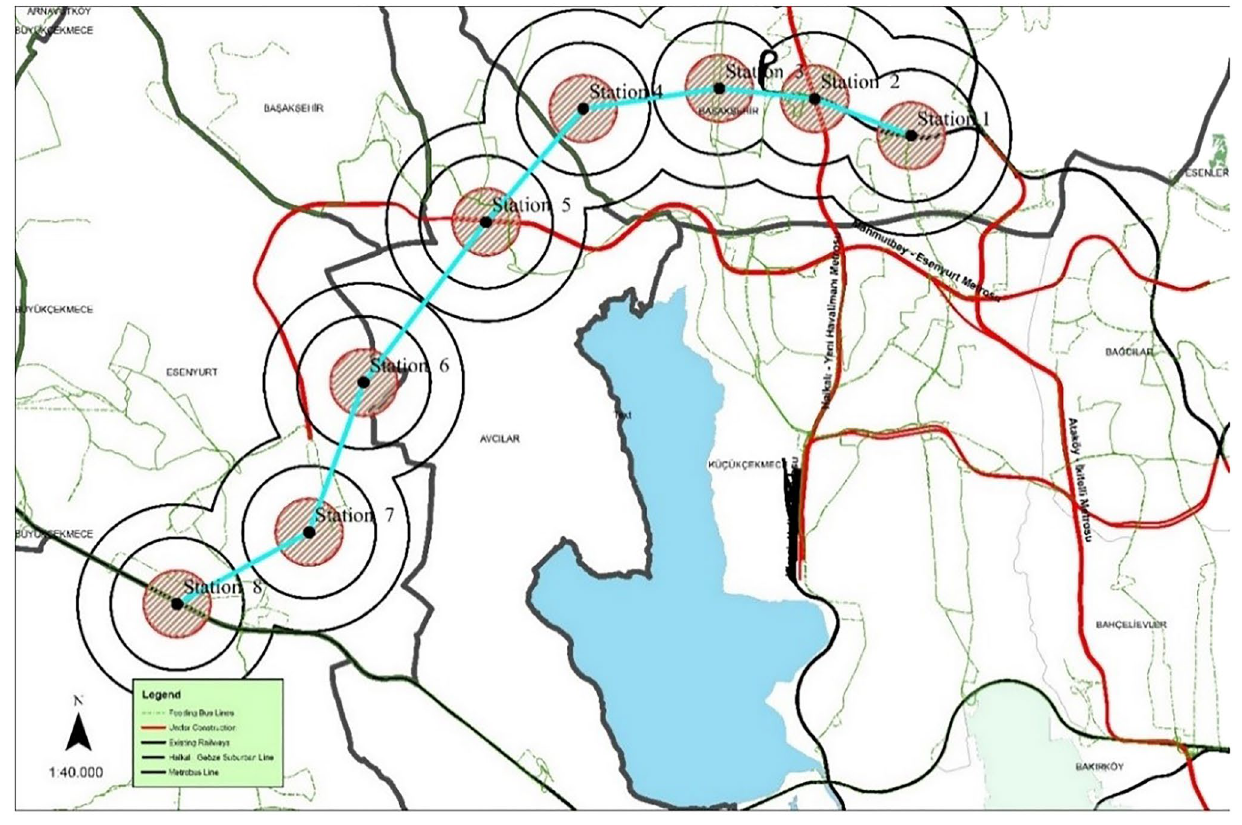
Fig. 10 Railway lines (existing and ongoing) and feeder bus lines (illustrated by